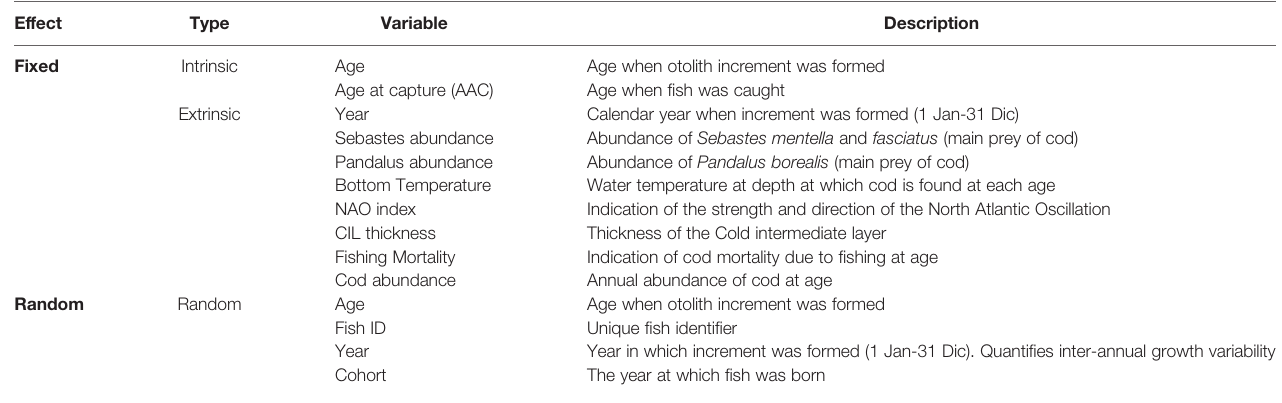
TABLE 1 | List of explanatory variables used as fi xed and random factors in the linear mixed-effects